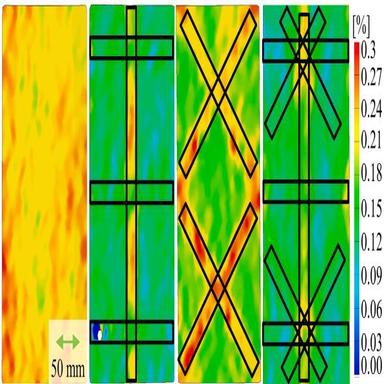
The strain map in the ROI 2 of 2D plates under 4-P flexural test (from left to right: pure SMC, 0/90, +45/− 45, and combined towpreg reinforced SMC.